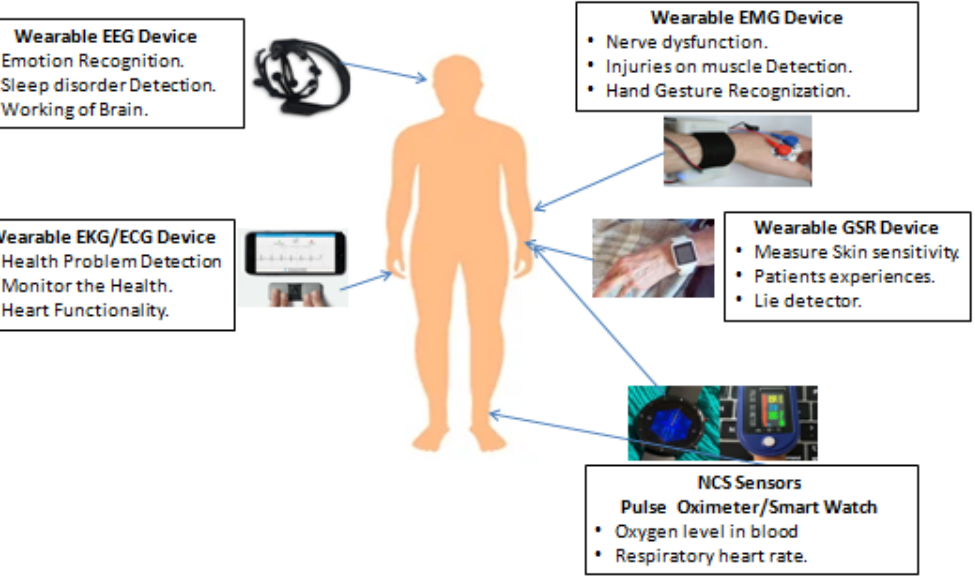
Figure 1. Different types of wearable bio-signal devices and utilities.